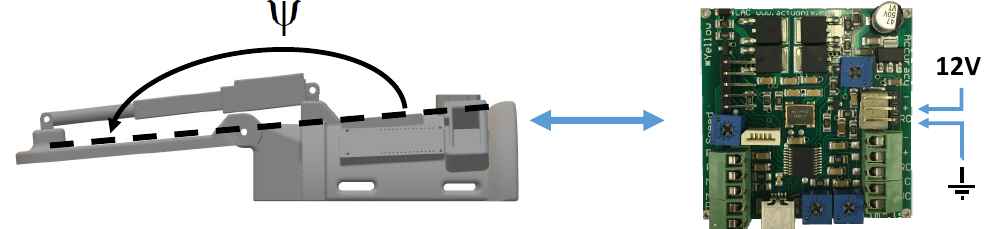
Figure 3. Overview of the hardware setup. The Arduino and Linear Actuator Control board were mounted on the exoskeleton. The EEG electrodes were connected through wires to the Open BCI board from which the signals were transmitted through wireless communication to the PC running OpenViBE. Once an imagined wrist extension was detected a trigger was sent through wireless communication to the Arduino on the exoskeleton. The Arduino was connected to the Linear Actuator Control board with a wire. The Linear Actuator Control board was powered with a 12 V power supply. The motor was connected to the Linear Actuator Control board with a